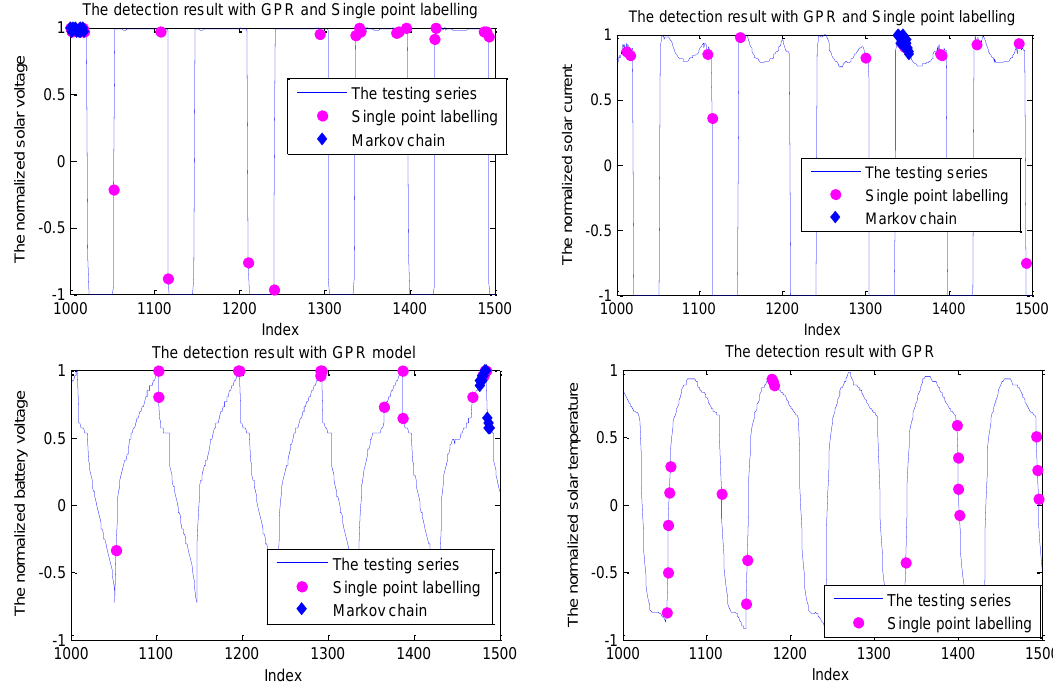
Figure 14. The detection results for the telemetry series with the GPR model.